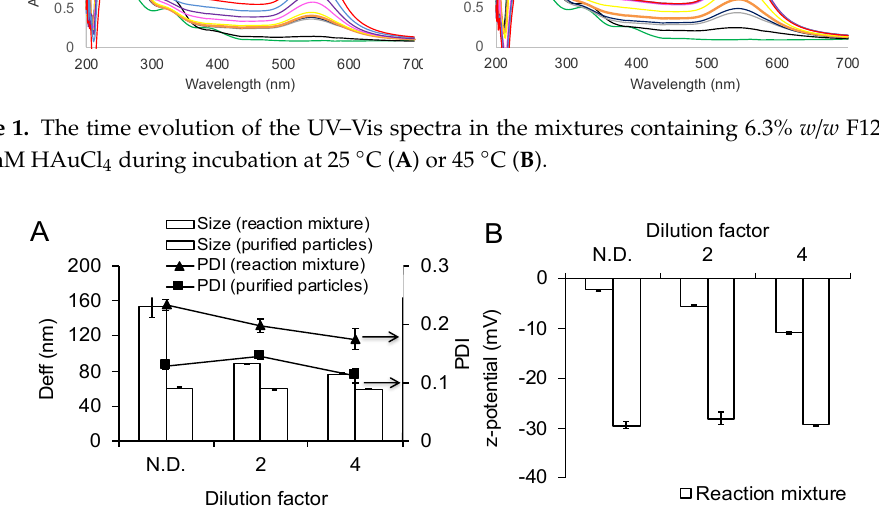
Figure 2. Changes in the ( A ) particle effective diameter (columns) and PDI (lines) and ( B ) ζ-potential following dilution of reaction mixture and purification of GNPs.